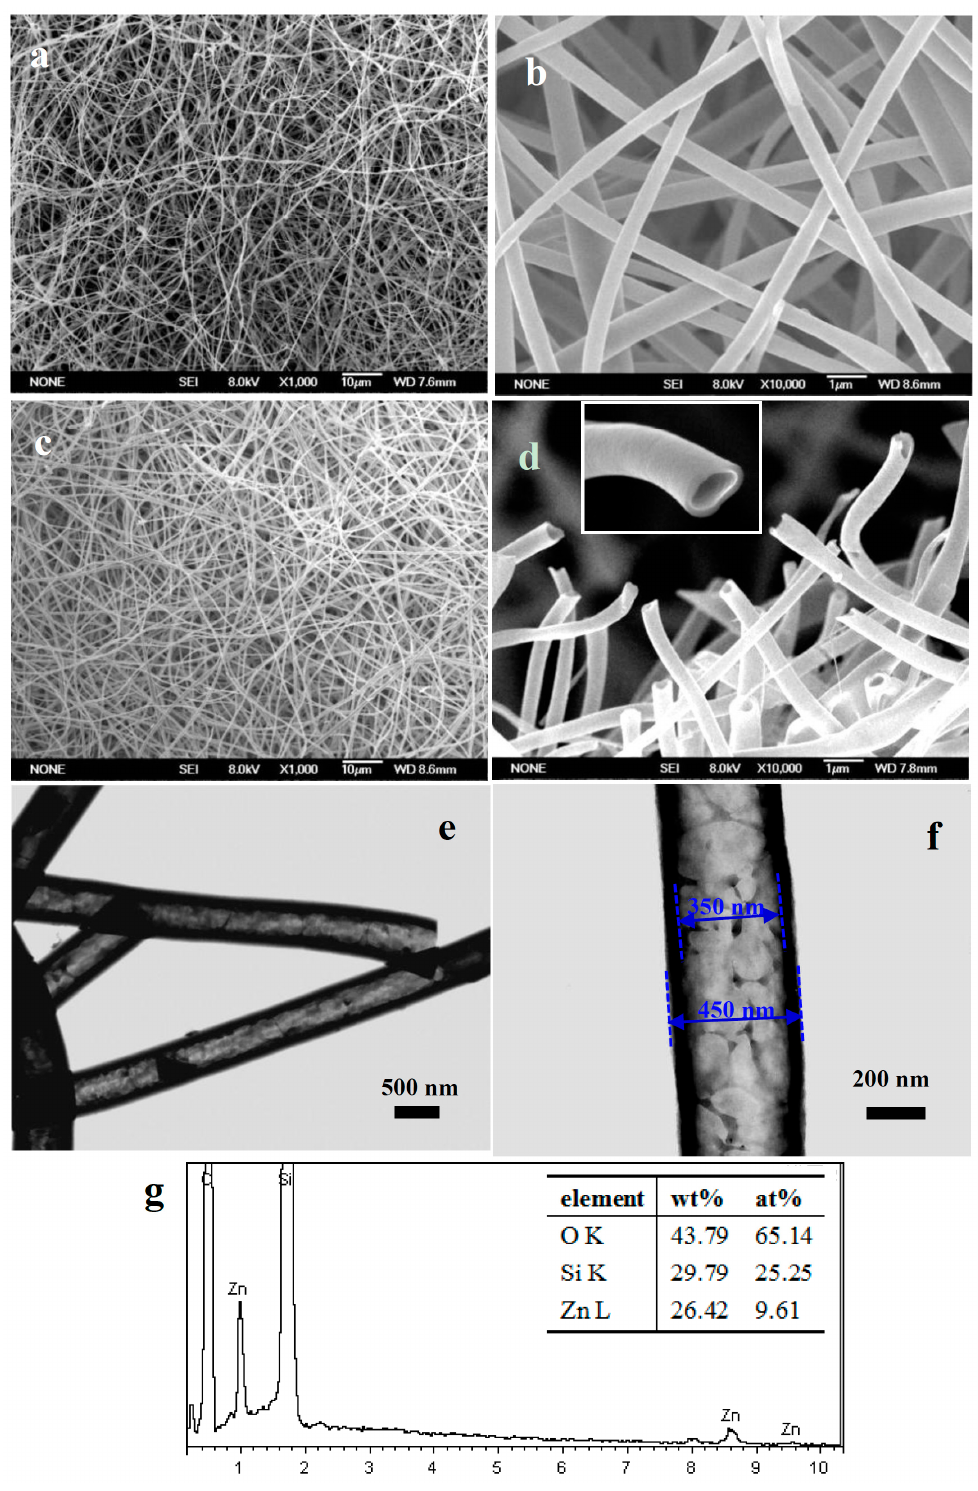
Figure 1. ( a ) low magnification and ( b ) high magnification scanning electron microscopy (SEM) images of as-spun precursor sub-micron fibers; ( c ) low magnification and ( d ) high magnification SEM images of SiO 2 /ZnO composite hollow sub-micron fibers and the cross-section of a single hollow nanofiber (the inset in ( d )); ( e ) low magnification and ( f ) high magnification TEM images of SiO 2 /ZnO composite hollow sub-micron fibers; ( g ) Energy-dispersive X-ray spectroscopy of the SiO 2 /ZnO composite hollow sub-micron fibers.